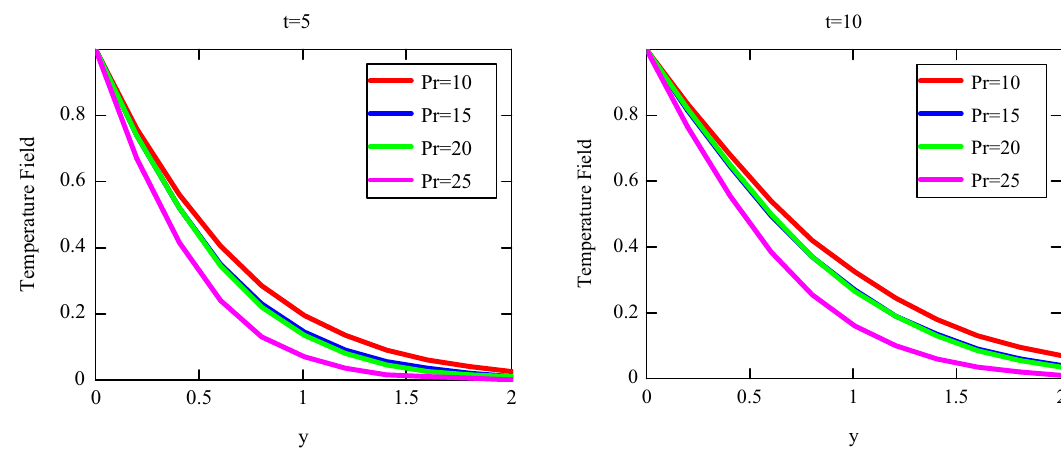
Figure 7: The fl uid temperature for the variation of the Prandtl number.